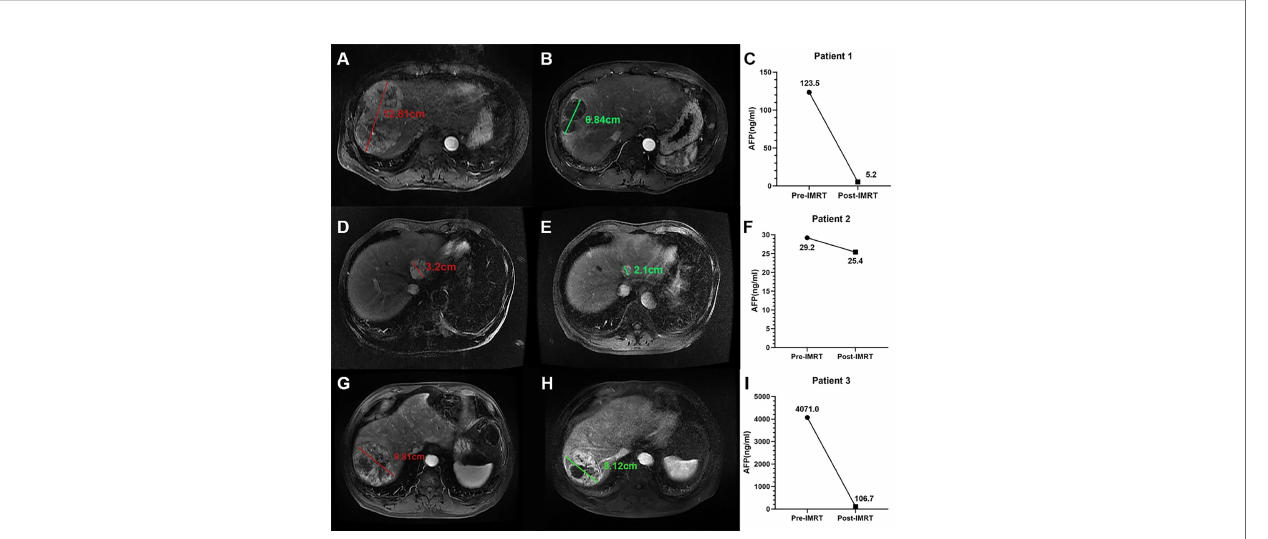
FIGURE 7 | Three example cases of PR de fi ned by the a -RECIST. (A, B) present the SLD on arterial phase images of pre- and post-IMRT CE-MRI scans for patient 1, and the size change is -42.0%; (C) presents the serum AFP levels before and after IMRT for patient 1, and the AFP D is -95.8%. (D, E) present the SLD on arterial phase images of pre- and post-IMRT CE-MRI scans for patient 2, and the size change is -34.0%; (F) presents the serum AFP levels before and after IMRT for patient 2, and the AFP D is -15.0%. (G, H) present the SLD on arterial phase images of pre- and post-IMRT CE-MRI scans for patient 3, and the size change is -17.0%; (I) presents the serum AFP levels before and after IMRT for patient 3, and the AFP D is -97.4%. For patient 1, both the size decrease and the AFP decrease degree exceed the threshold values; For patient 2, only the size decrease degree exceed the threshold value; For patient 3, only the AFP decrease degree exceed the threshold value. All the three patients are de fi ned as PR by a